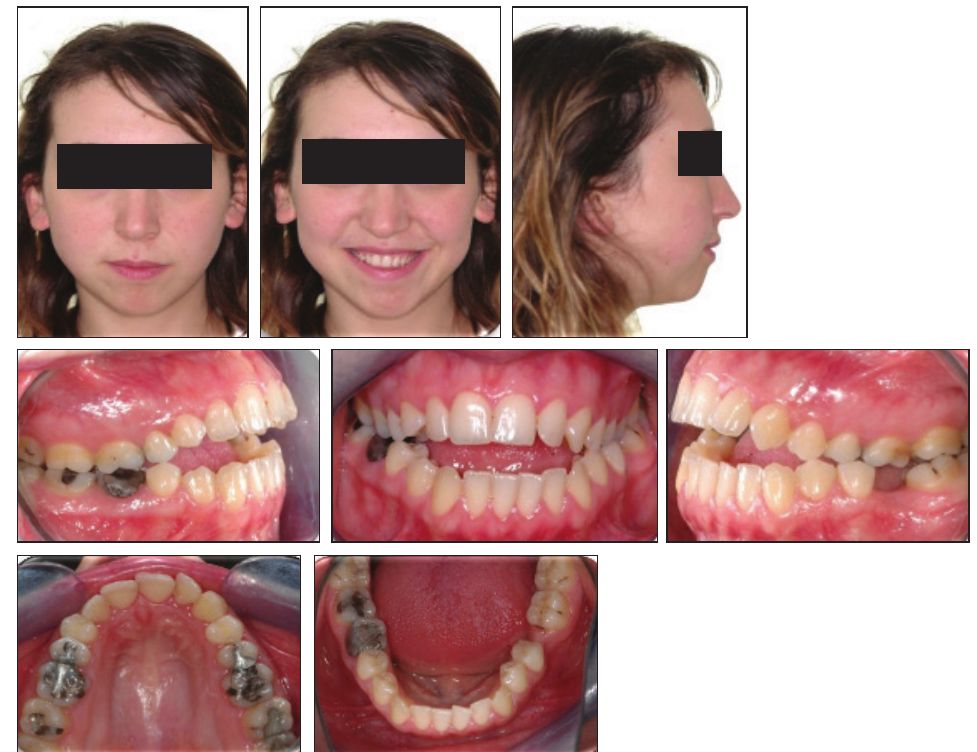
Figure 1. Pretreatment extra- and intra-oral photographs of the